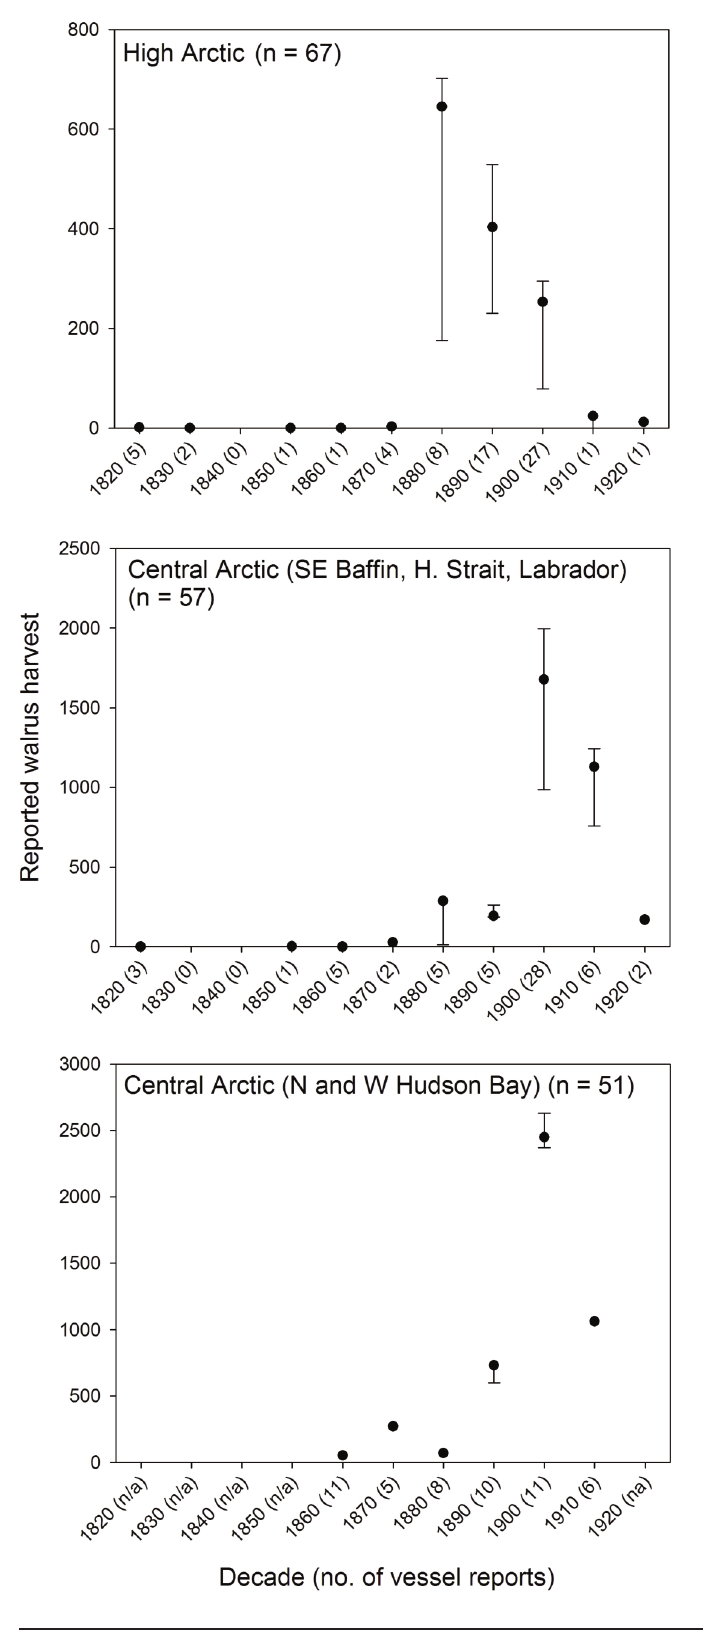
Fig. 11. Uncertainty in the numbers of walrus caught by commercial whaling vessels resulted from con- siderable variation between the minimum, best (solid circles), and maximum catch estimates (see text). Variation among these three esti- mates differed among wal- rus populations and among